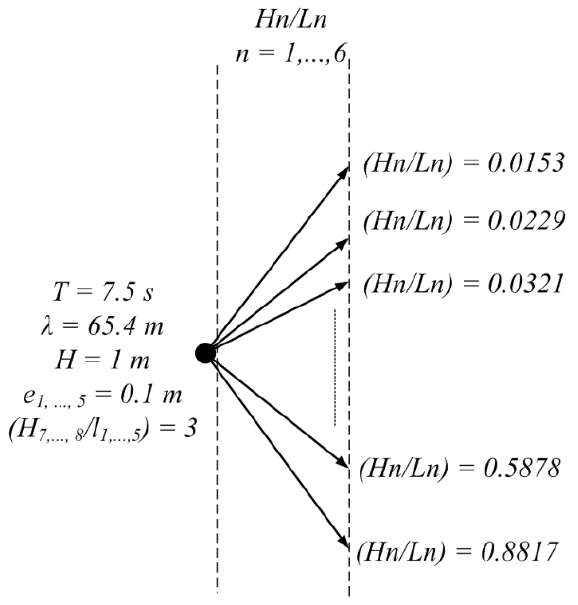
Figure 7. Representation of the analyzed cases and their degrees of freedom.